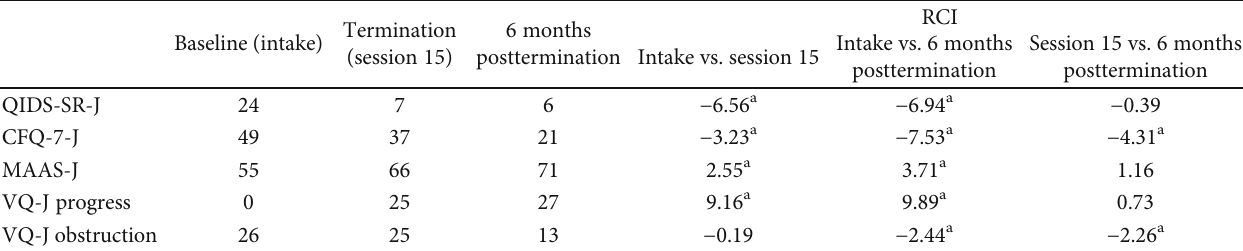
Figure 3: Symptom and process measures from the intake to 6-month posttermination of sessions. QIDS-SR-J =Quick Inventory of Depressive Symptomatology Self Report-Japanese; AAQ-II-J=second version of the Acceptance and Action Questionnaire-Japanese; CFQ-7-J=Cognitive Fusion Questionnaire-7 Japanese; MAAS-J =Mindful Attention Awareness Scale-Japanese; VQ-J =Valuing Questionnaire-Japanese. Table 1: